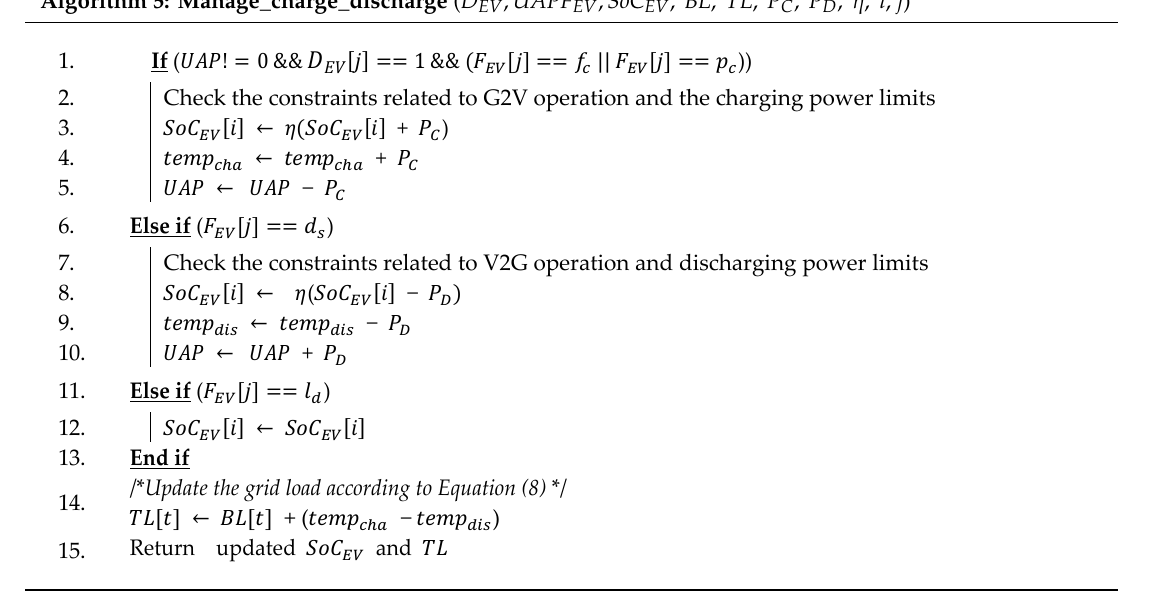
Algorithm 6: Manage_departure ( N EV , SoC EV , SoC req